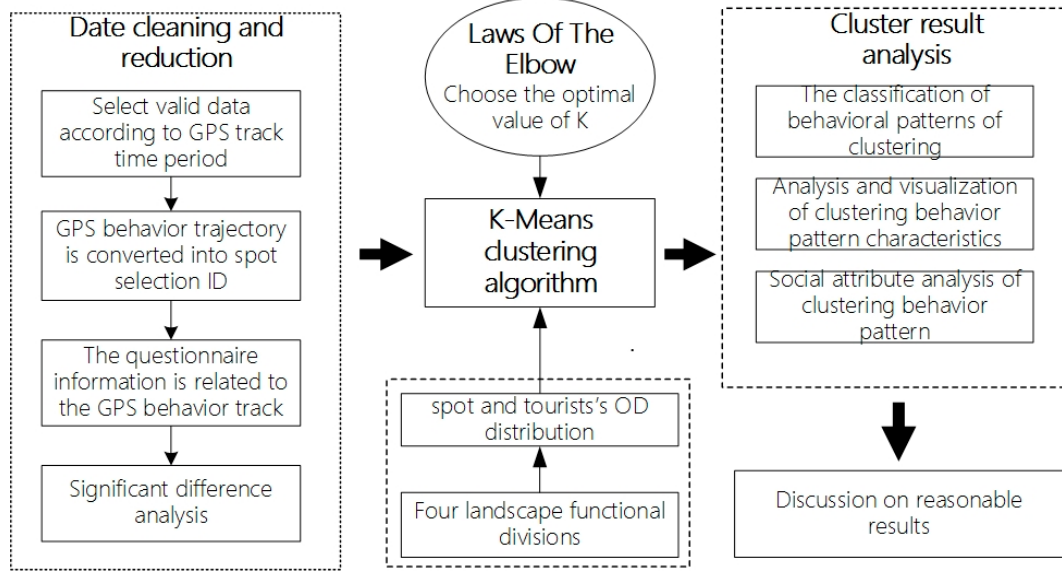
Figure 2. Framework for the study.